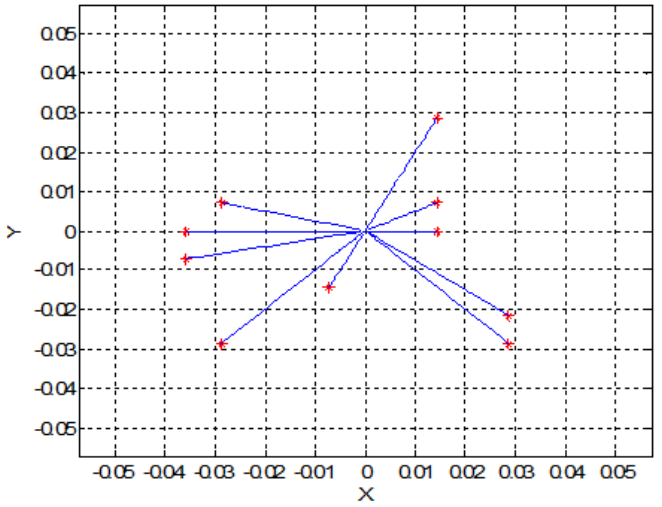
Figure 3. Trajectory of the nine nanoparticles in the effect of one magnetic field source (units are mm).